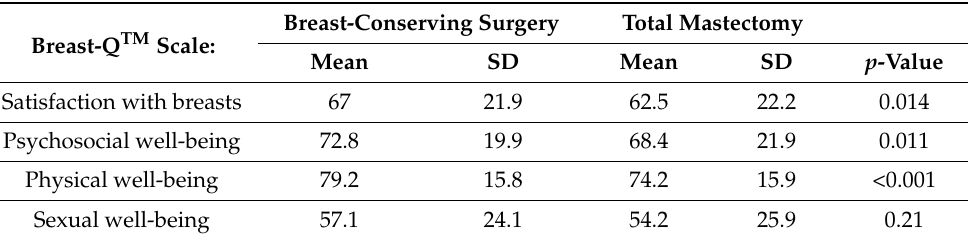
Table 5. Patient-reported outcome statistics presented for the Breast-Q TM stratified by breast- conserving surgery and mastectomy.